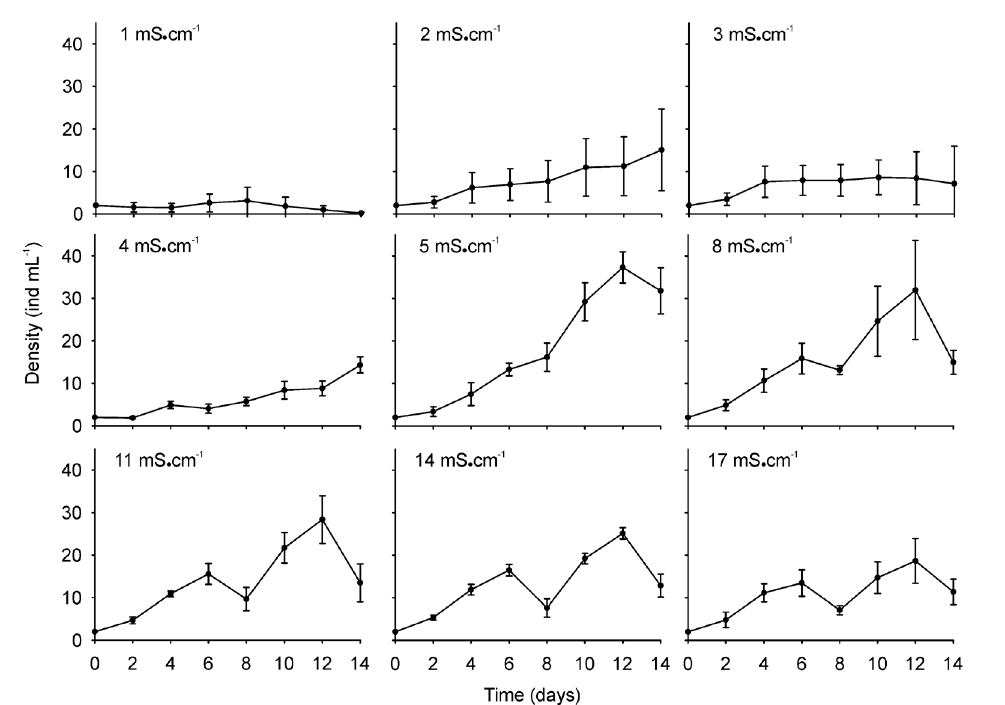
Figure 1 - Population growth of Brachionus plicatilis at different conductivities (1 – 17 mS.cm –1 ). Mean values ± standard error are shown based on four biological